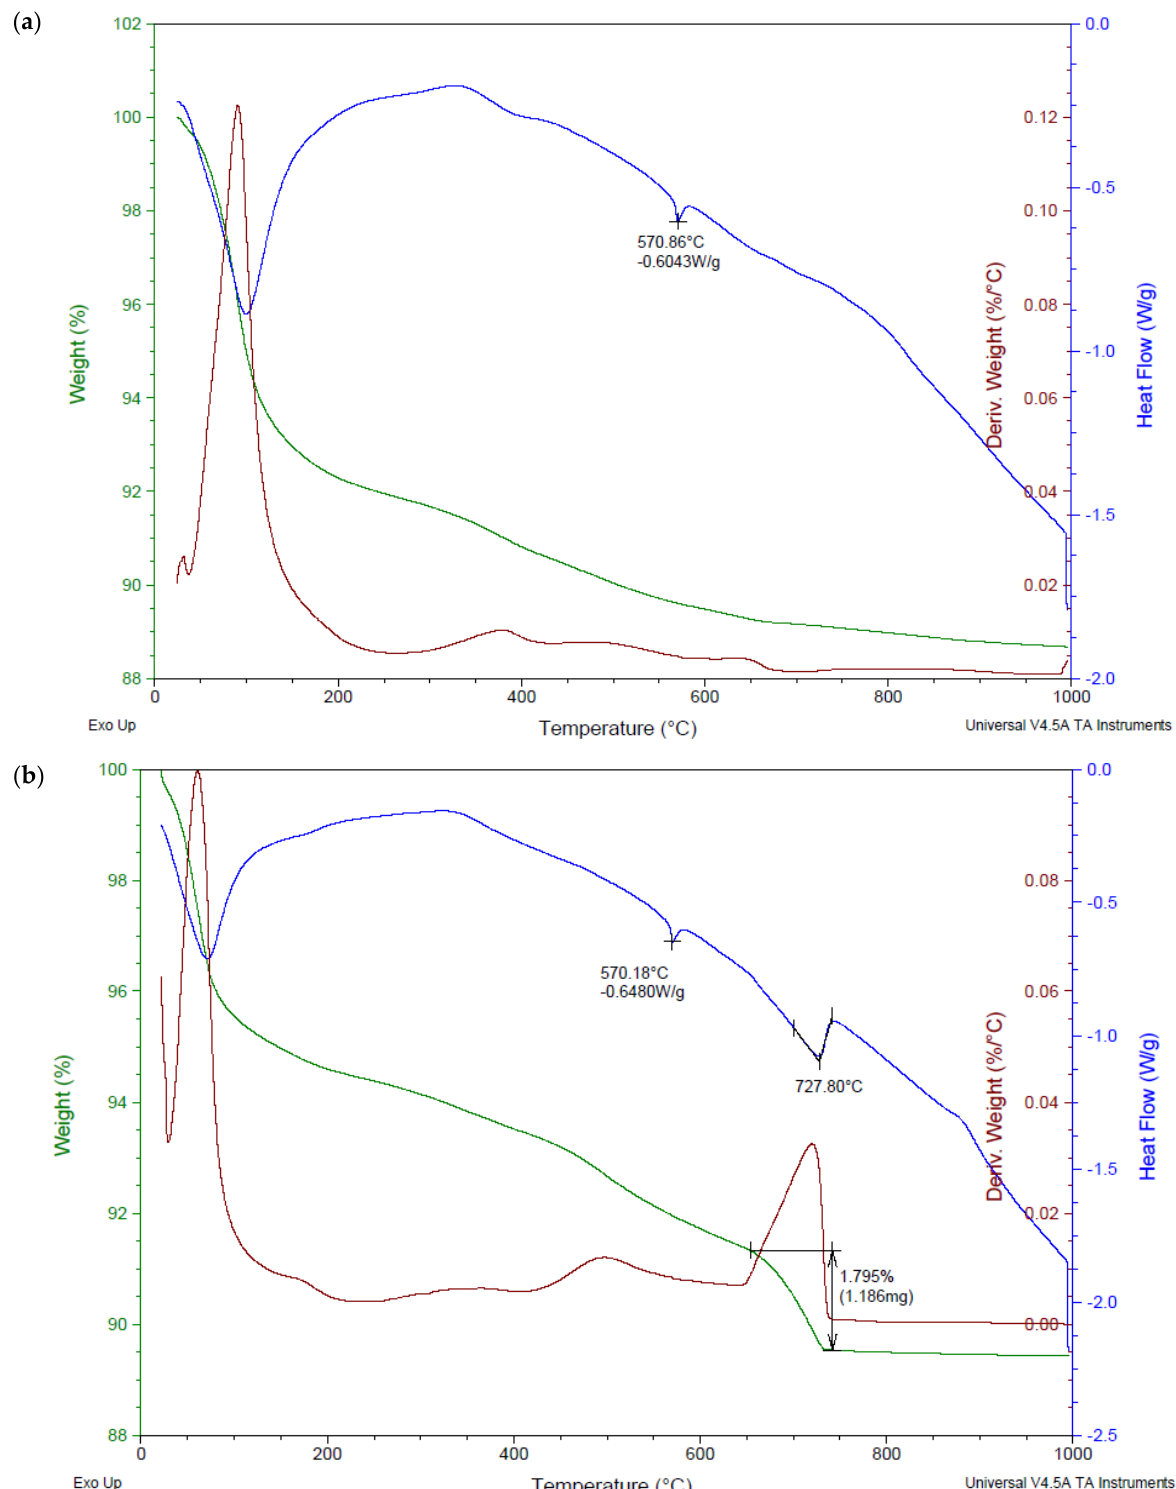
Figure 9. Thermal analysis REC 2 ( a ) indoor storage ( b ) in situ storage.